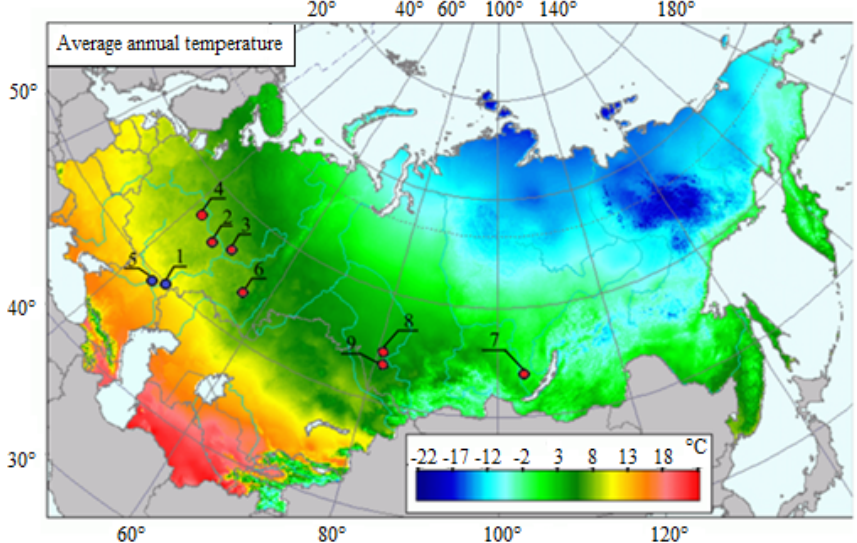
Figure 8. The location scheme for the modified TPPs with BPSTs in Russia. Blue point—for case 2a; red point—for case 2b.